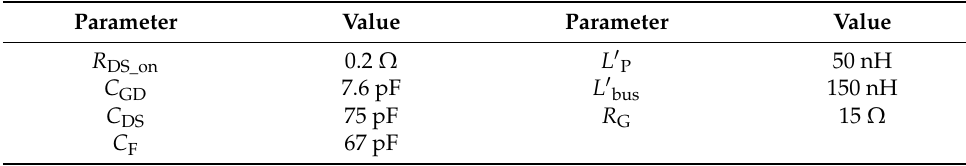
Figure 4. Amplitude–frequency curves of the terminal impedances, Z d_1 and Z m2_1 , with different C DE ( a ) at Stage 4 and ( b ) at Stage 7 and Stage 8. Table 1. Parameters for drawing the amplitude–frequency